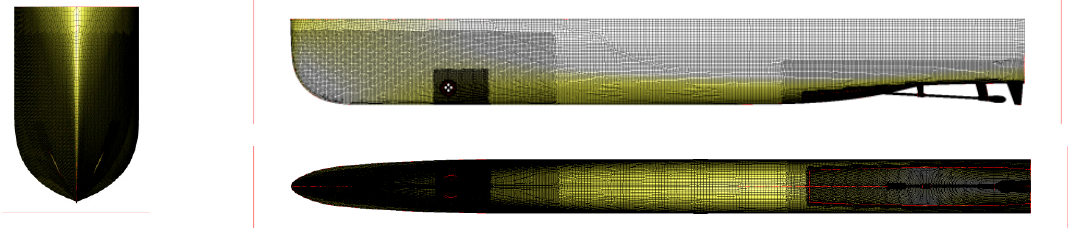
Figure 7. Computational domain of FreSCo+ and 5.7 M mesh used for the resistance and propulsion simulation .